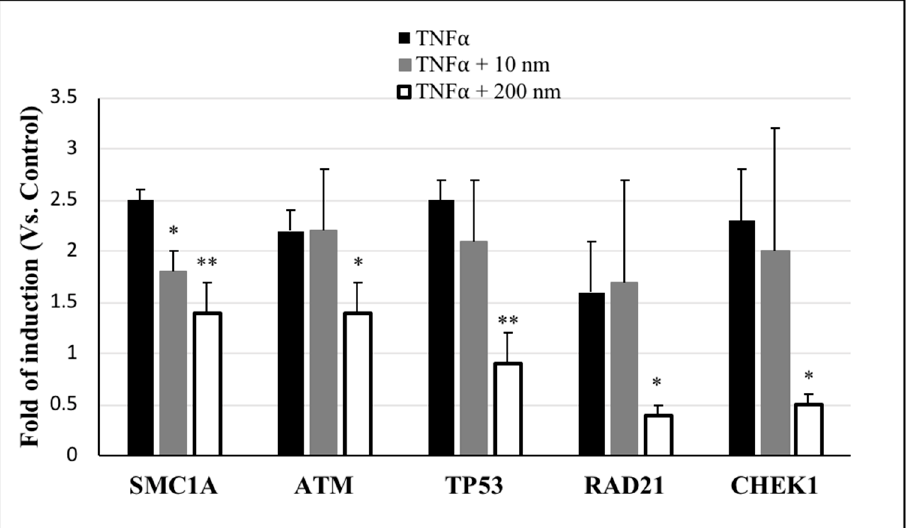
Profiler PCR Array. Fold regulation values more than 1 were considered as positive regulation (upregulation).